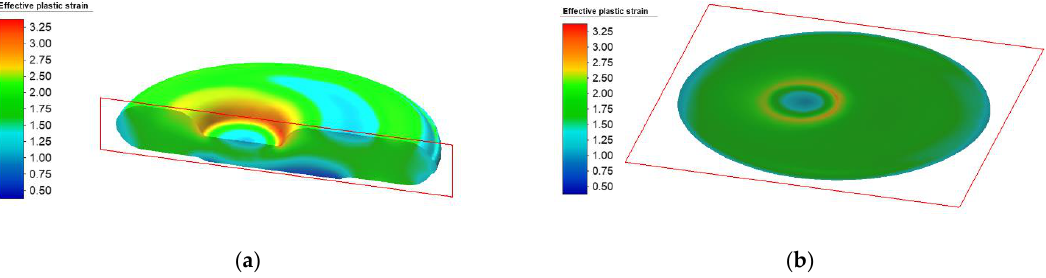
Figure 12. E ff ective plastic strain values of cam after the forging process with AA-5083-N0 as a starting material (most unfavourable study case) ( a ) where the first plane of cut (in red) is a cross-section plane located at the middle of the width of the cam and ( b ) the second plane of cut (in red) is a longitudinal plane located at the middle of the height of the